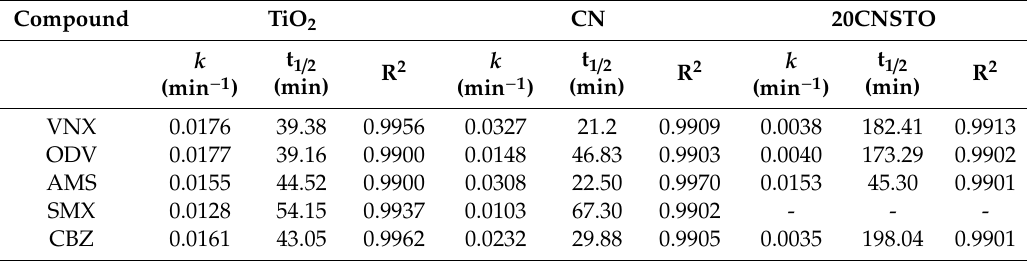
Table 4. Kinetic parameters of PhACs photocatalytic degradation in hospital wastewater e ffl uent using TiO 2 , CN and